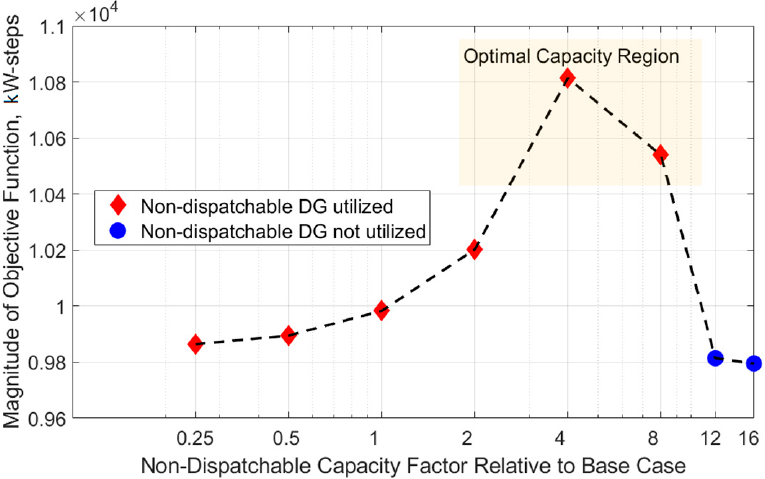
Figure 6. Estimating Non-dispatchable DG’s Optimal and Threshold Capacity under the Same Operating Conditions.